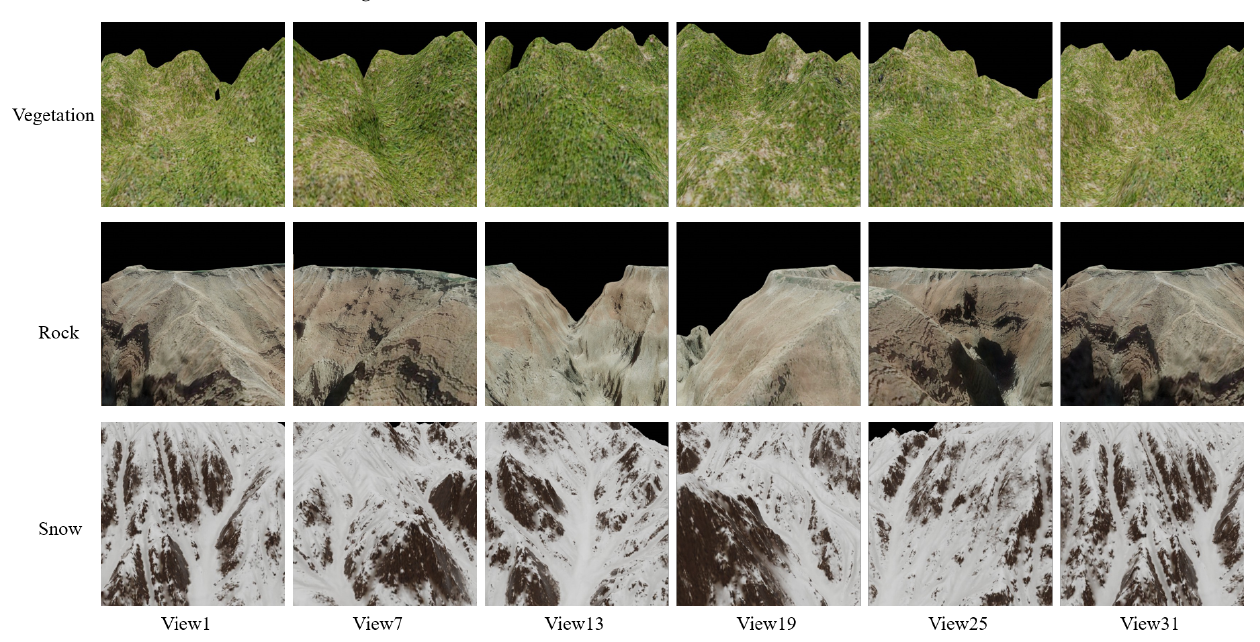
Figure 7. Input images of six camera views corresponding to each type of mountain terrain in the testing